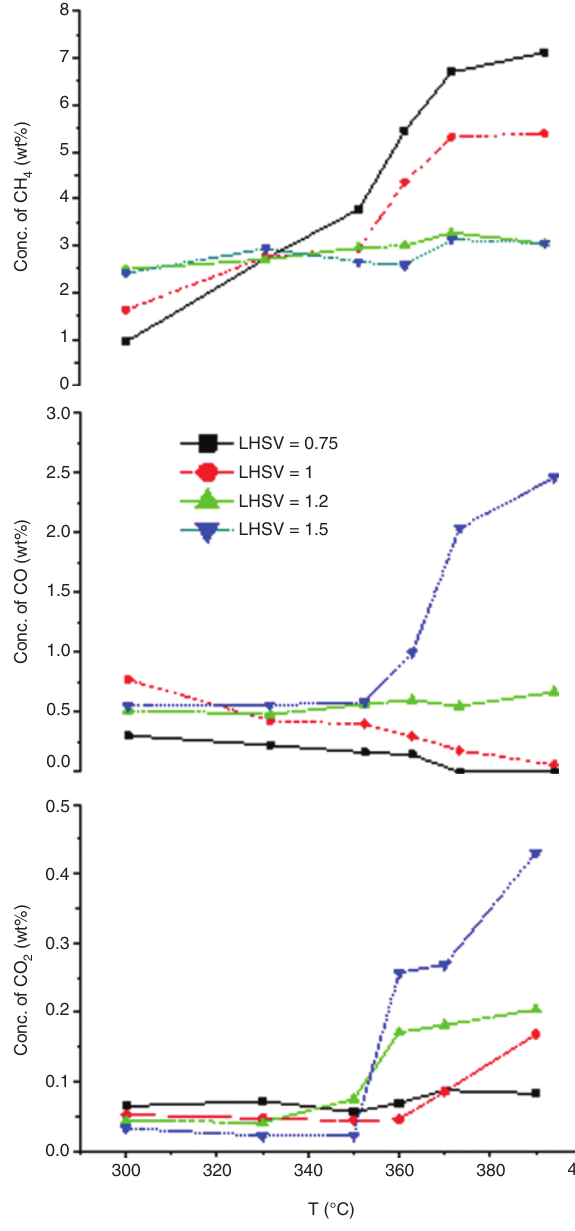
and CH concentration in the gas outlet with ele- Figure 4: CO, CO 2 4 vated temperature and space velocity at 5 MPa pressure. Here, liquid hourly space velocity (LHSV) was ■ 0.7, ● 1.0, ▲ 1.2 and ▼